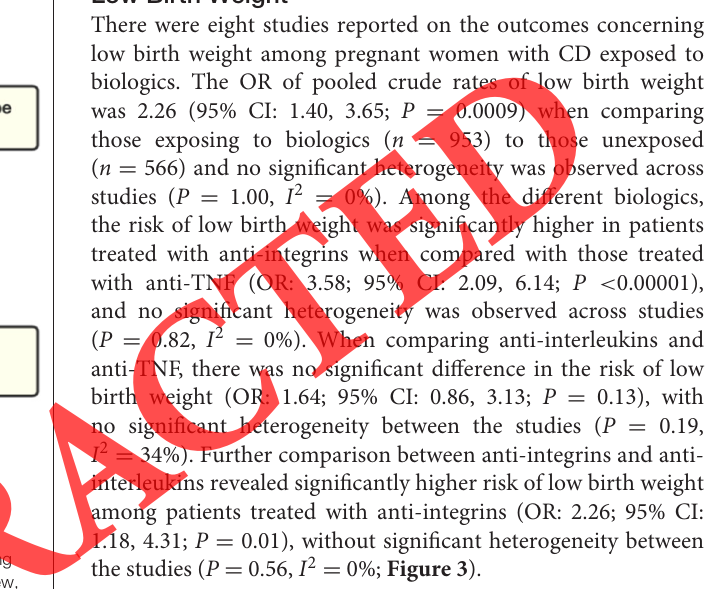
FIGURE 1 | Study flow diagram. Records identified by database searching and from gray literature. Sixty-five articles met the criteria for full-text review, with 11 finally included in the